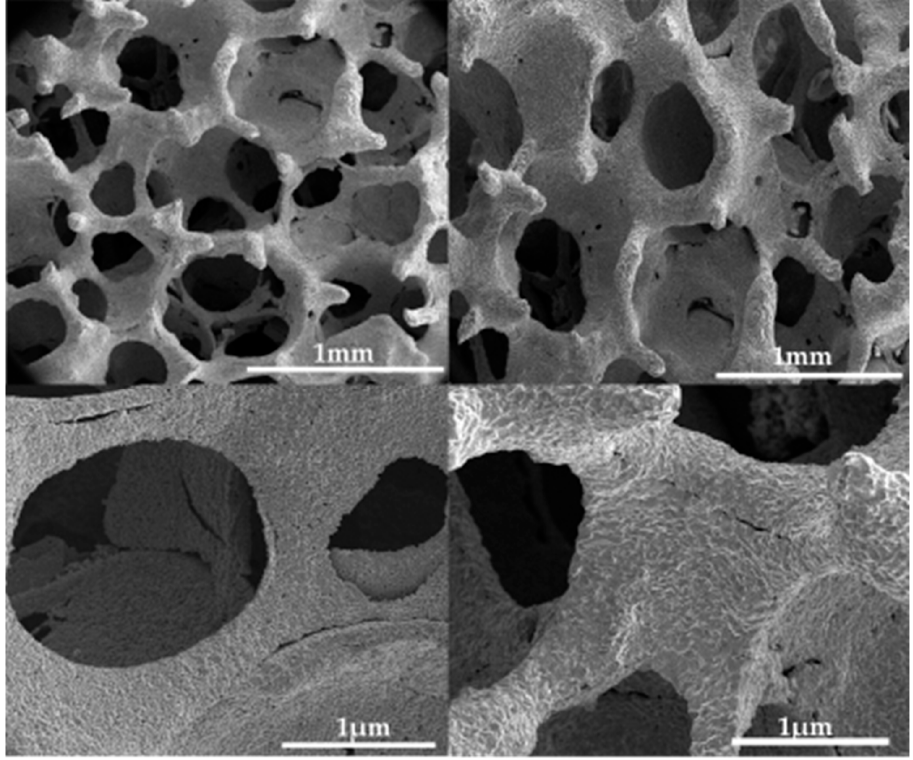
Figure 2. Scanning electron microscopy (SEM) images of synthesized Fe